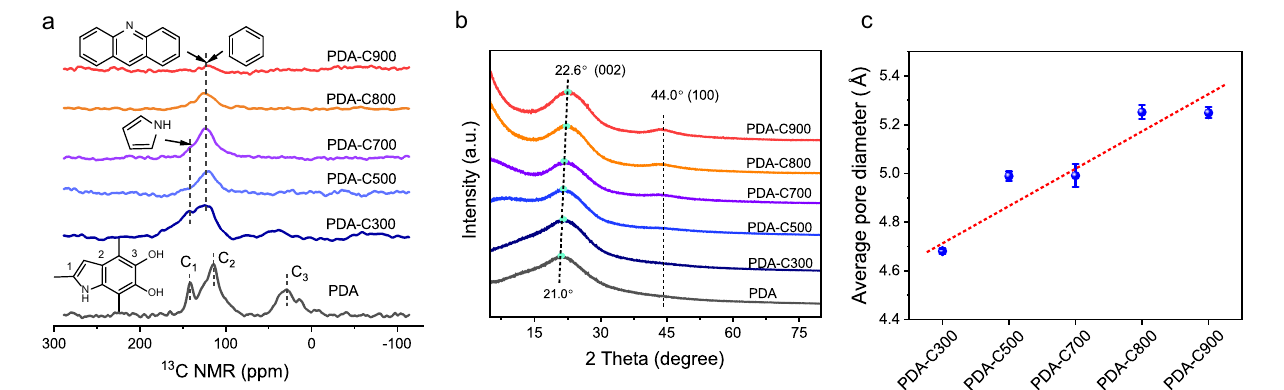
Fig. 2 | Characterization of PDA and PDA-Cx. a 13 C CP MAS NMR experiments recorded on PDA and PDA-Cx; b PXRD patterns of PDA and PDA-Cx. The dotted lines mark the (002) and (100) peaks; c The average pore size of PDA-Cx derived